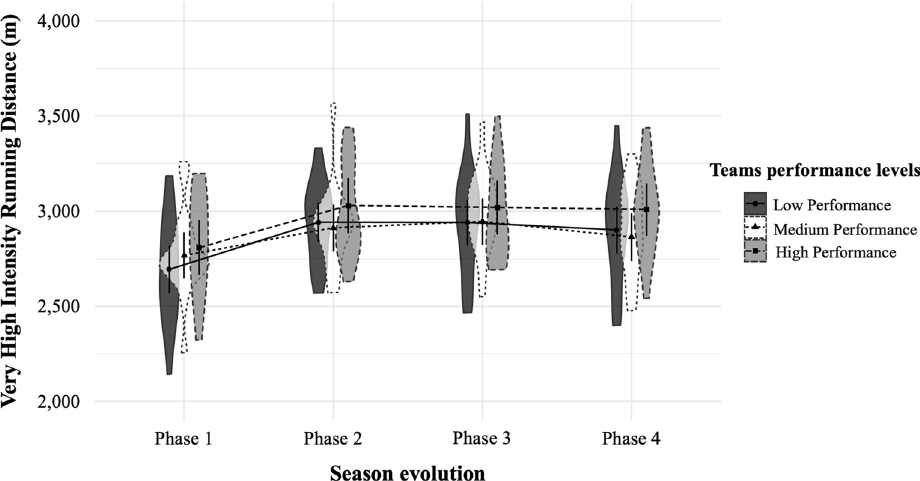
Figure 4. Very high-intensity running distance (> 24 km h −1 ) covered in meters ( M ± SD ) by teams with high, medium and low performance in the different phases of the seasons 29 . m meters.